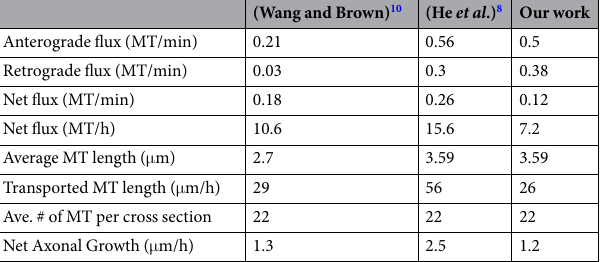
Table 1. Quantitative analysis of rapid MT transport. Data compare two prior studies, with our findings. Anterograde flux and retrograde flux refer to the number of MTs that move past a point along the axon over a given period of time in the respective directions. Net flux is determined by subtracting retrograde flux from anterograde flux. The transported length of MTs per hour is calculated by multiplying net flux by the average length of the transported MTs. Since that parameter was not measured in our study, we used the larger of the two values 8 from the previous studies. Rochlin et al . 16 reports a value of 22 MT/axonal cross section in sympathetic neurons, which have a similar morphology to sensory neurons. Net axonal growth is calculated by dividing transported MT length over time by the average number of MTs per axonal cross